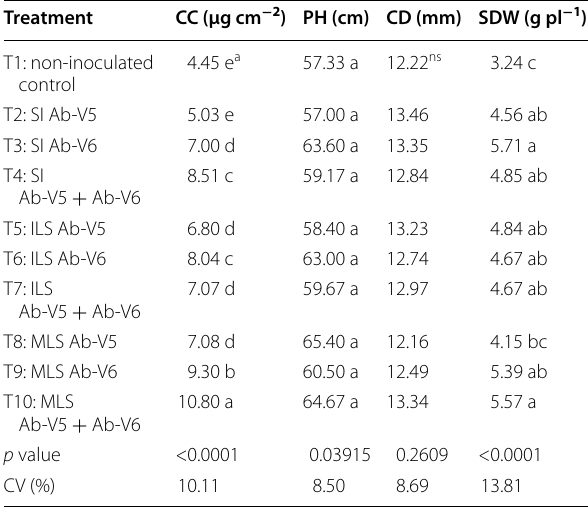
Table 2 Effects of inoculation with Azospirillum brasilense strains Ab-V5 and Ab-V6 applied via seeds (seed inocula- tion, SI, at sowing) or by foliar application (inoculation by leaf spray, ILS, at the V2.5 stage) and of application of their metabolites (MLS) at the V2.5 stage on the chloro- phyll content (CC), plant height (PH), culm diameter (CD) and shoot dry weight (SDW) of maize plants (DKB330 VT